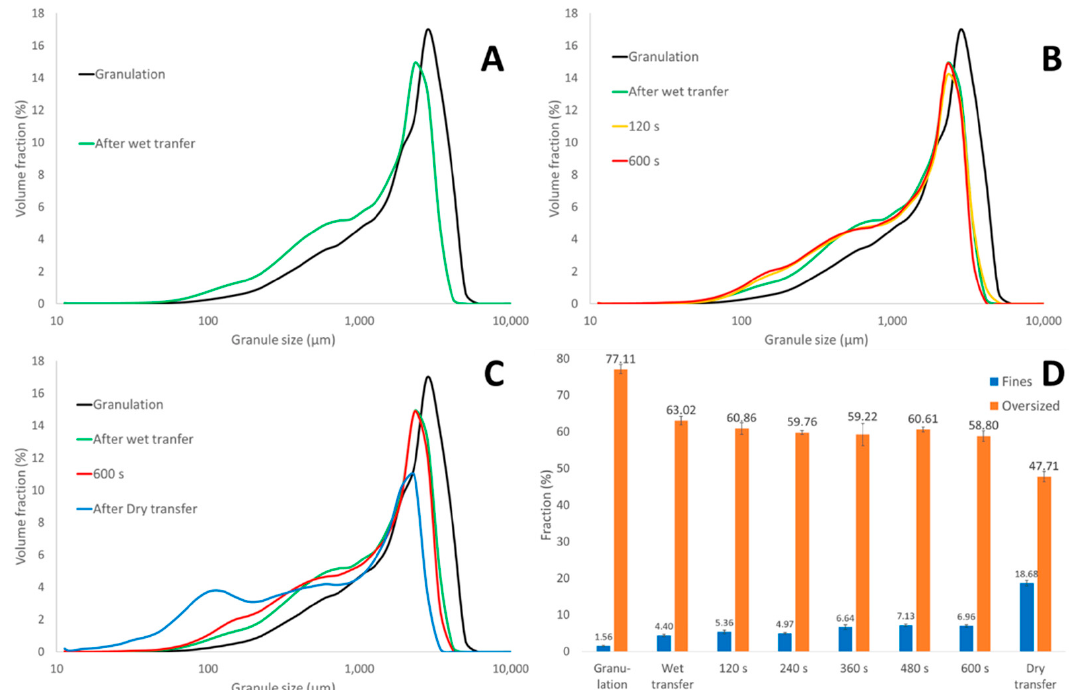
Figure 4. Granule size distributions to study the effect of the transfer via the wet transfer line ( A ), the drying process ( B ), and the transfer of the dried granules via the dry transfer line ( C ). The fraction in fines and oversized granules is shown at different drying times and along the length of the C25 ( D ).